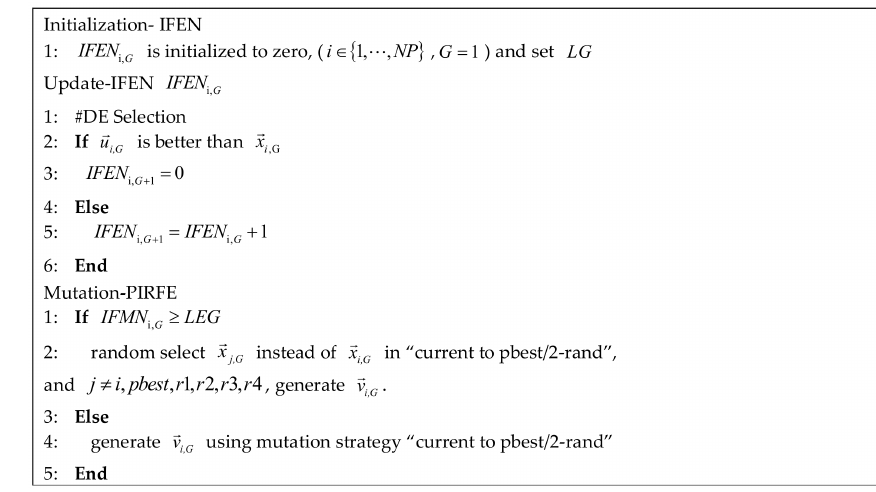
Figure 3. Pseudocode of PIRFE